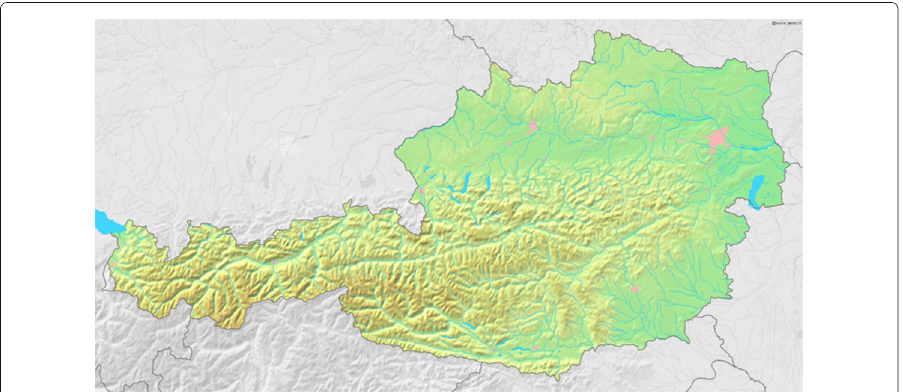
Fig. 2 Topographical map,